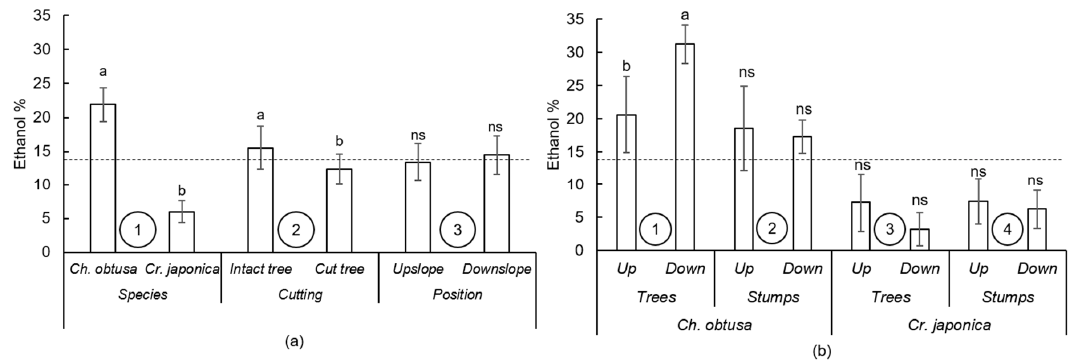
Figure 4. The effect of tree species ( Ch. obtusa and Cr. japonica ), cutting (intact tree and cut tree plots), and position (upslope and downslope) on soil water repellency (SWR) intensity (generalized linear model) ( a ). Comparison of SWR intensity between upslope and downslope of individual Ch. obtusa and Cr. japonica trees and stumps ( b ). Small letters and ns denote significant and non-significant differences in each treatment, respectively. Soil samples are from 5 cm depth. Error bars indicate the standard error (SE).